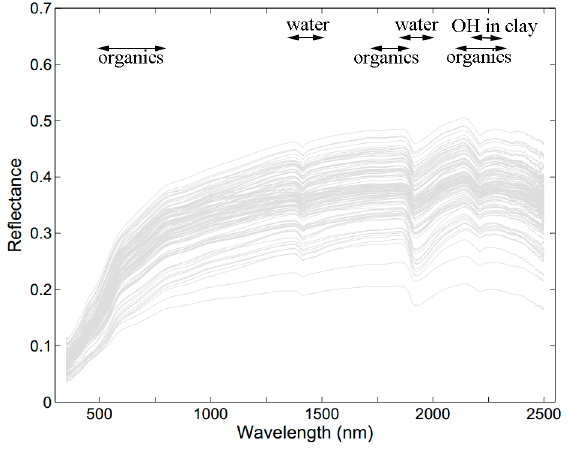
Figure 2. The spectral reflectance of soil samples ( n = 106). The principal positions of spectral absorption by organics and water are highlighted.